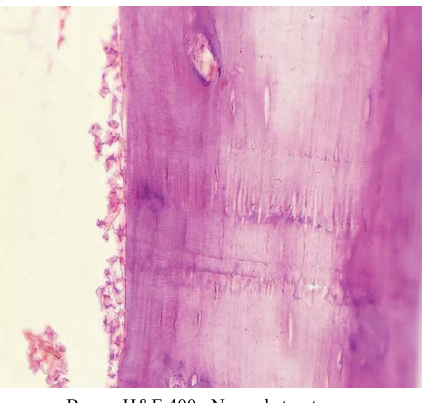
Bone - H&E 400x Normal structure. Fig. 7. Histopathology of decalcified bone of group 7 (Ginger in diab.Group) .